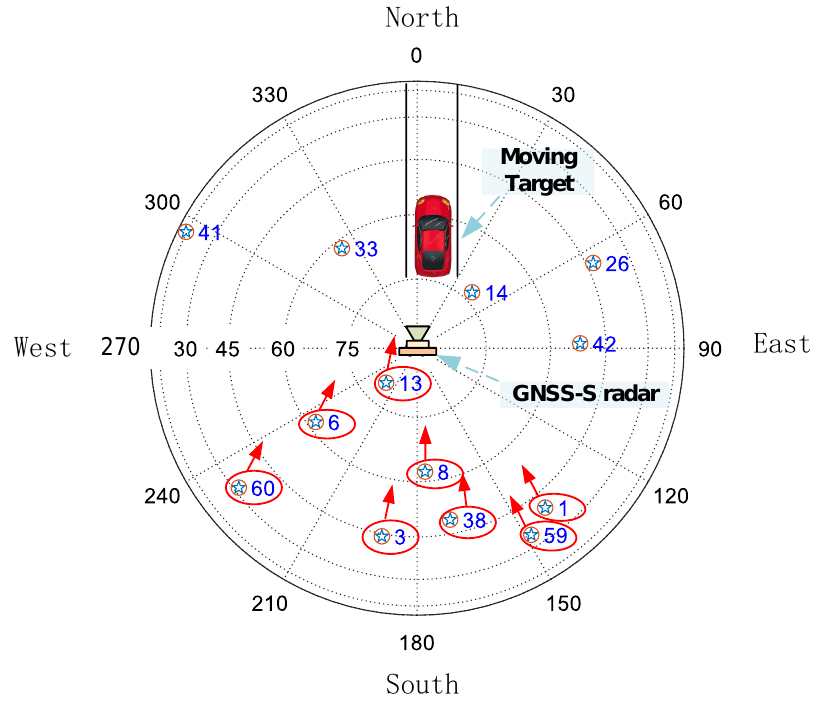
Figure 14. BDS satellite distribution and relative position.